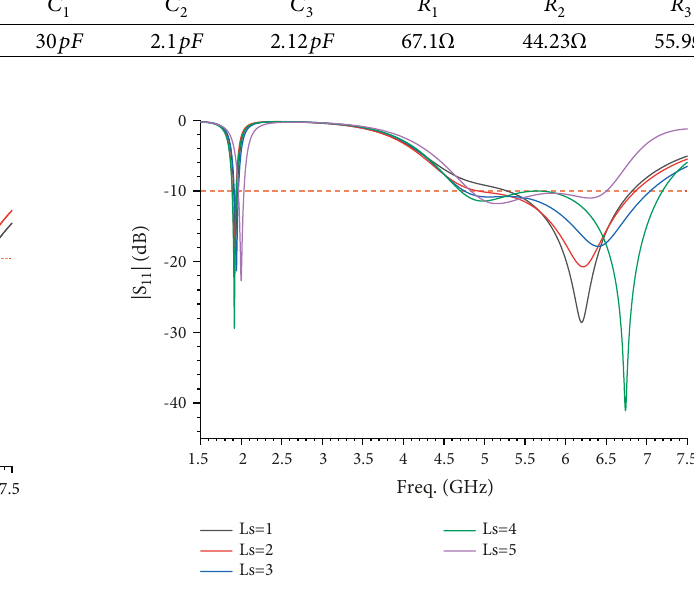
Figure 11: |S11| of the EC and HFSS.